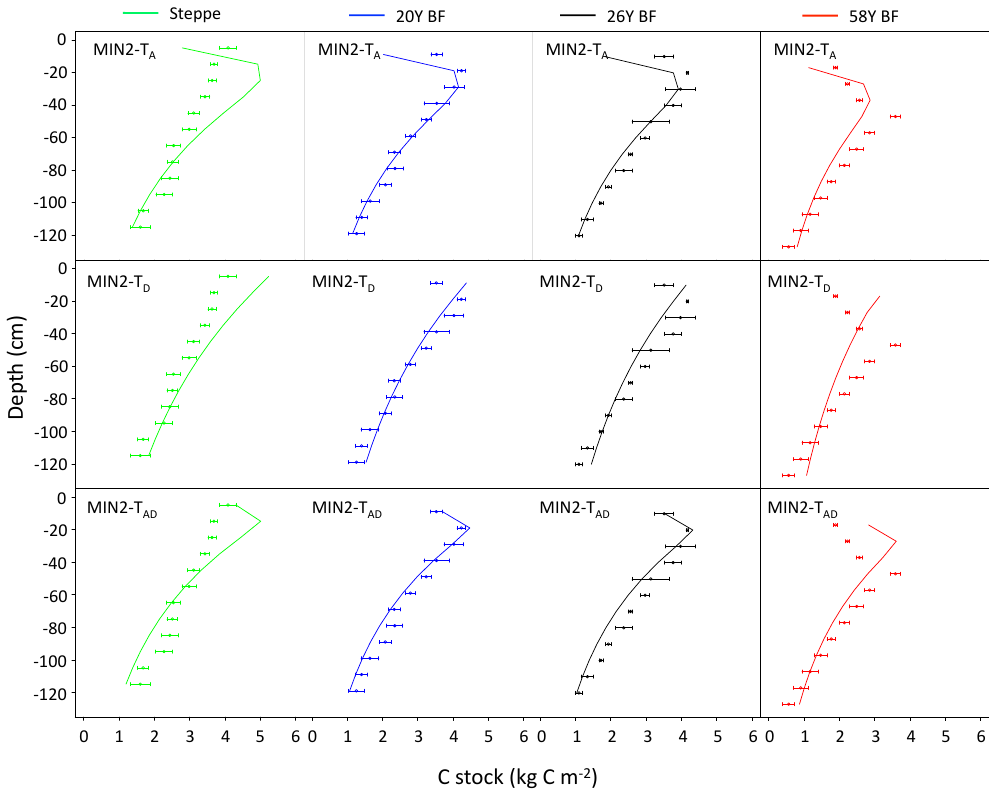
Fig. 5. Total Organic Carbon for the MIN2 transport scheme (priming model) and the three transport schemes ( T A , T D , T AD ) . Measured C stocks are represented by the circles and modelled C stocks by the lines.